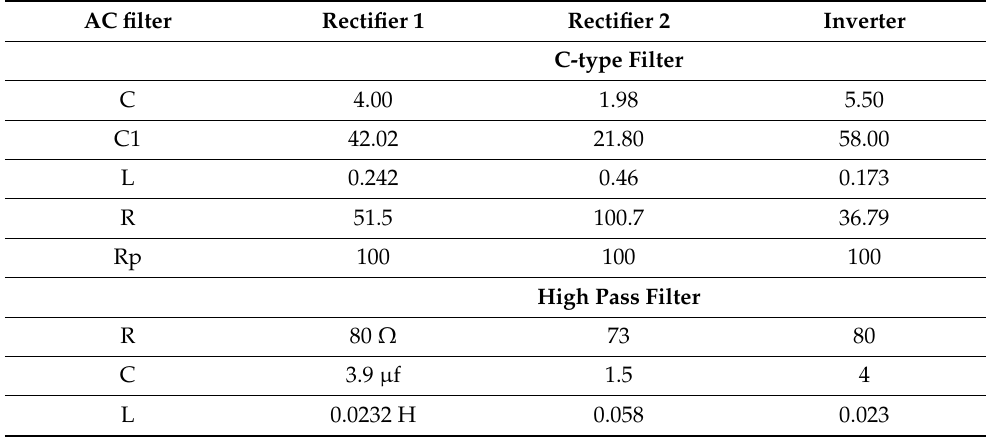
Table A5. Filter design.